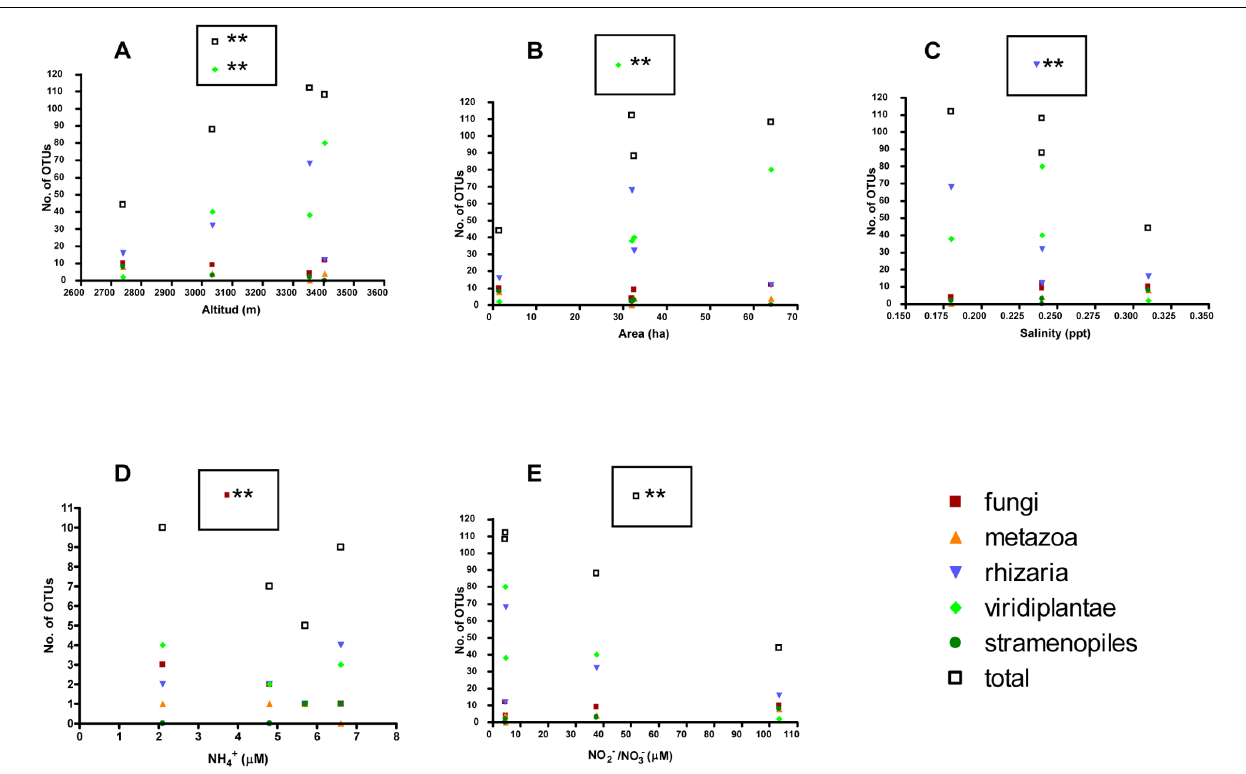
FIGURE 5 | Correlation analysis between protist taxa from glaciers and environmental variables. Number of OTUs in glaciers with respect to environmental parameters: (A) Altitude; (B) area; (C) salinity; (D) NH + 4 ; (E) NO − 2 / NO − 3 ; statistical differences were studied by Pearson’s r (* p < 0.05 and ** p <